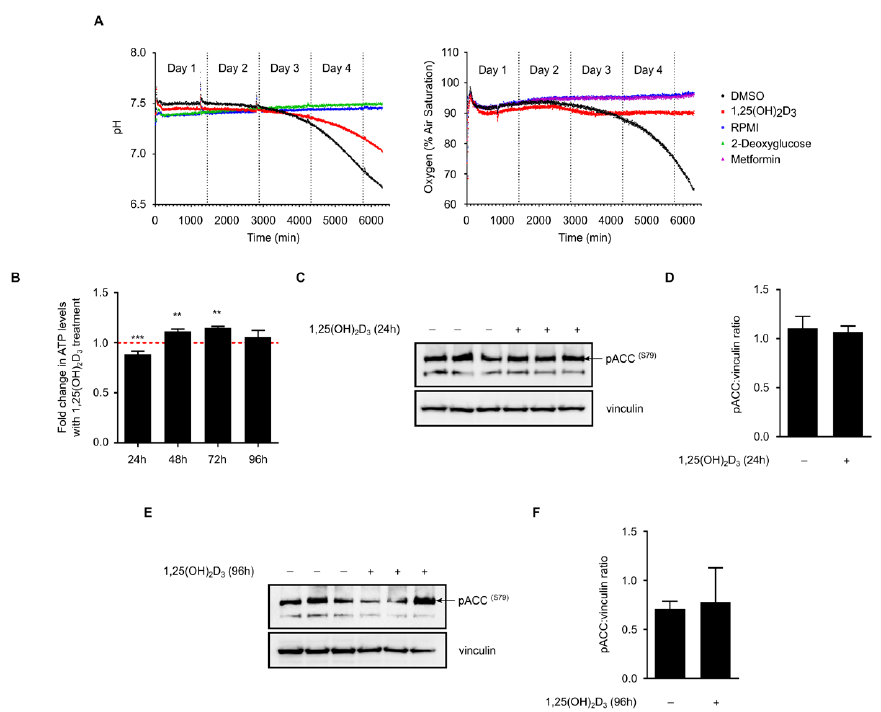
Figure 5. 1,25(OH) 2 D 3 does not profoundly impact glucose metabolism but influences overall energy status. ( A ) On-line measurements of culture medium pH and amount of dissolved oxygen in response to different treatments over a time course of four days. Culture medium without cells (RPMI) was used as calibration reference for the measurement of both parameters. 2-deoxyglucose (10 mM) and metformin (2 mM) were used as additional controls for pH or oxygen measurements, respectively. 1,25(OH) 2 D 3 treatment did not predominantly influence glucose metabolism in HL-60 cells. Differences